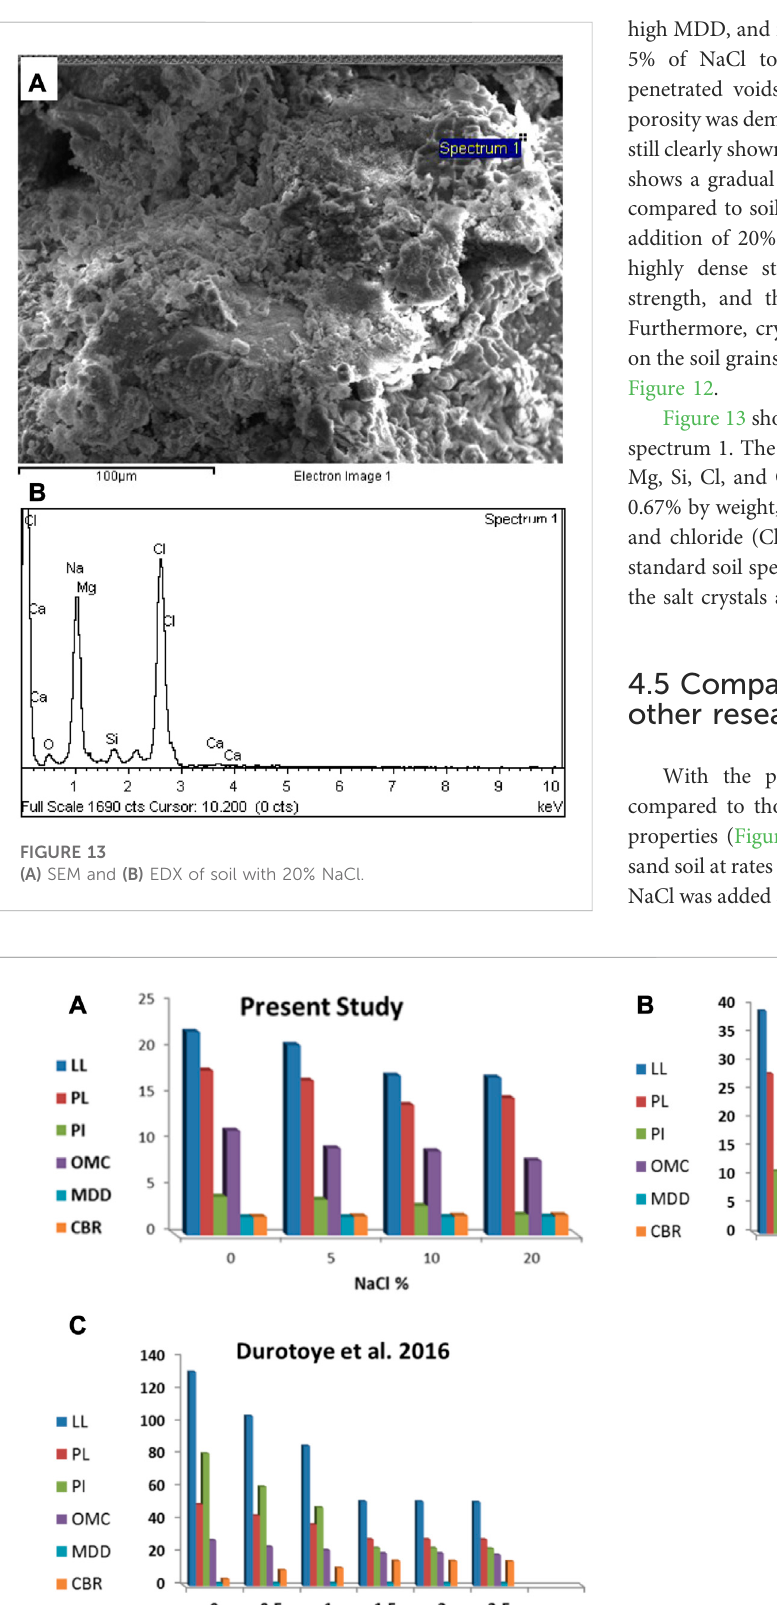
Frontiers in Environmental